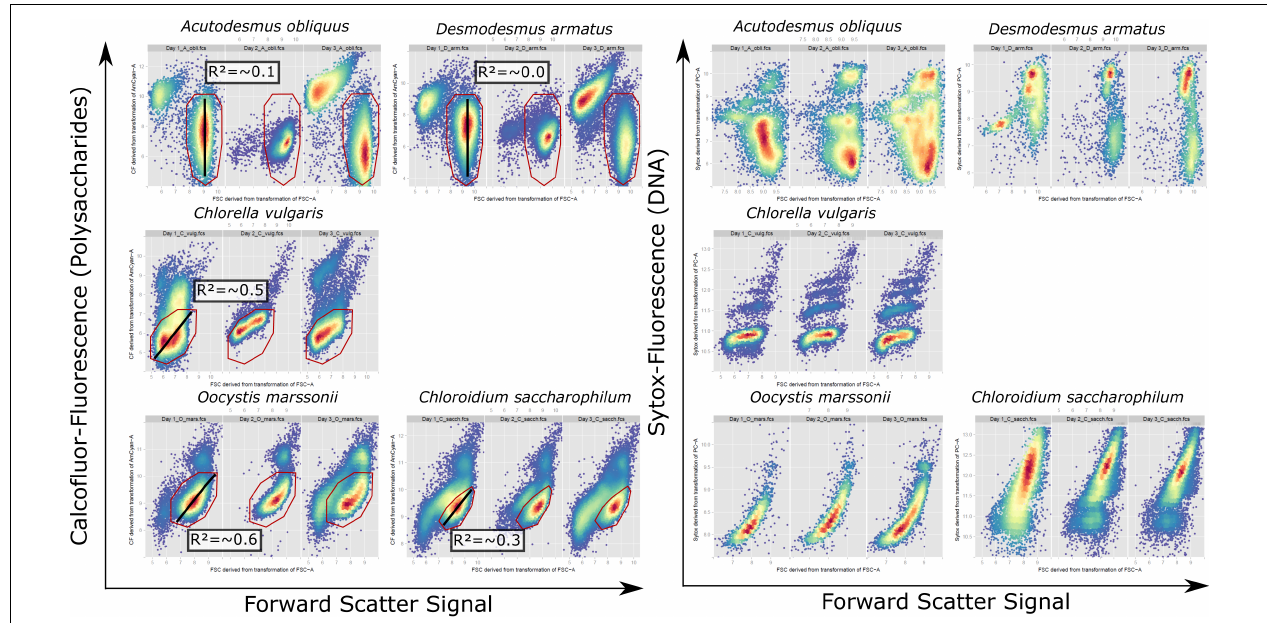
FIGURE 2 | Cytometric pattern for FSC signal against Calcofluor fluorescence signal of vital cells and FSC-Signal against Sytox fluorescence signal of fixed cells for A. obliquus , D. armatus , C. vulgaris , O. marssonii, and C. saccharophilum from representative exemplary control cultures on day 1, 2, and 3. Bottom-right, high density population, was used for correlation of single cell values for FSC signal against Calcofluor fluorescence (red gate). Black line indicates the respective regression line and the mean regression coefficient for measurements over 1 week is given in the respective